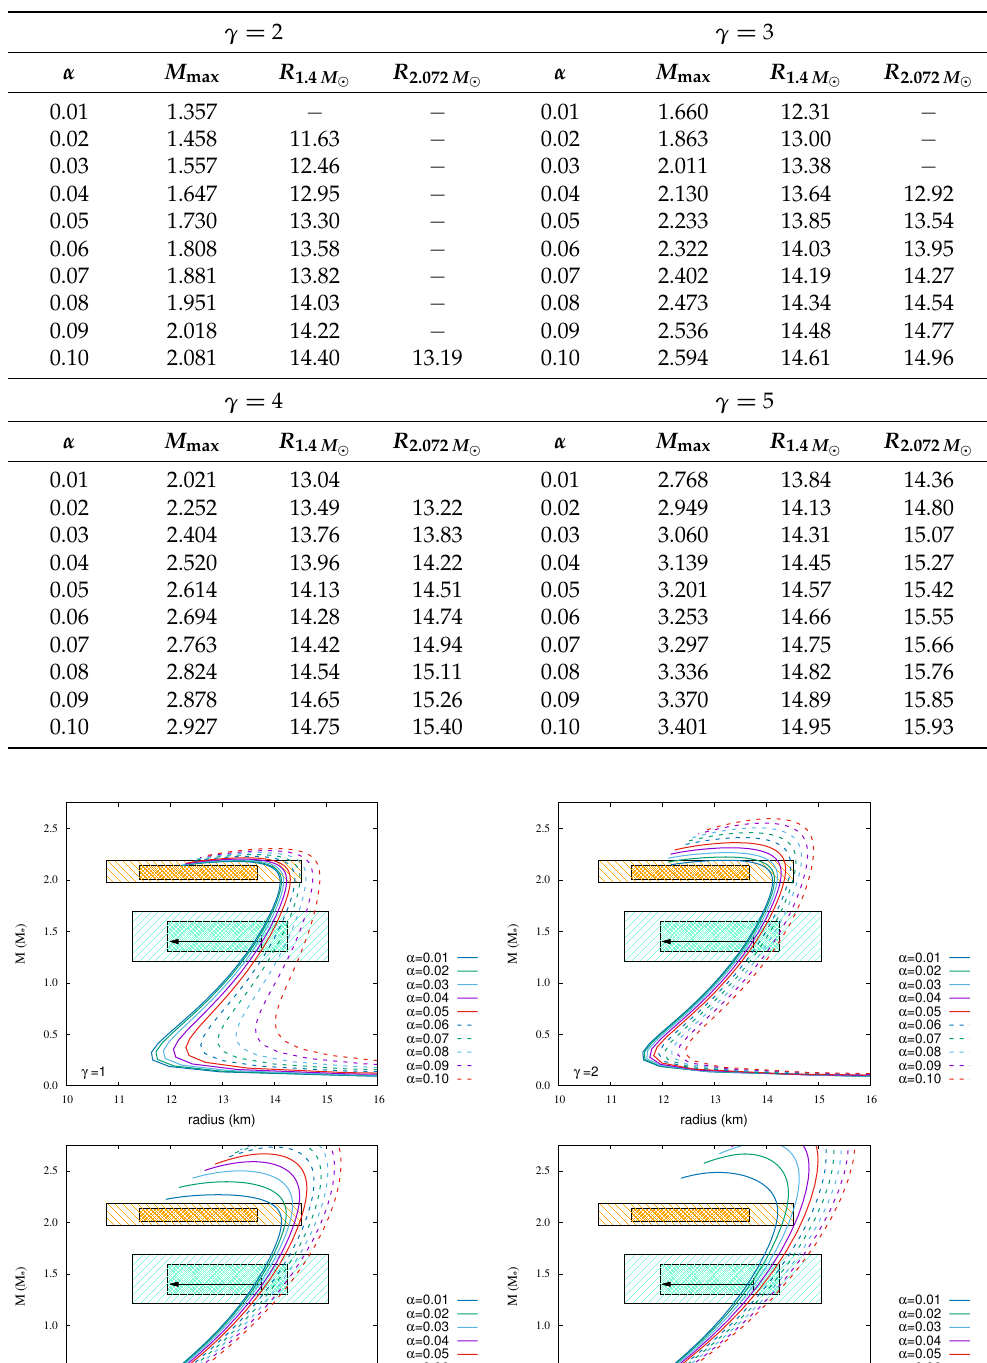
Table 6. Maximum mass ( M max ) in unit of M (cid:12) and radius (km) at M = 1.4 M (cid:12) ( R 1.4 M